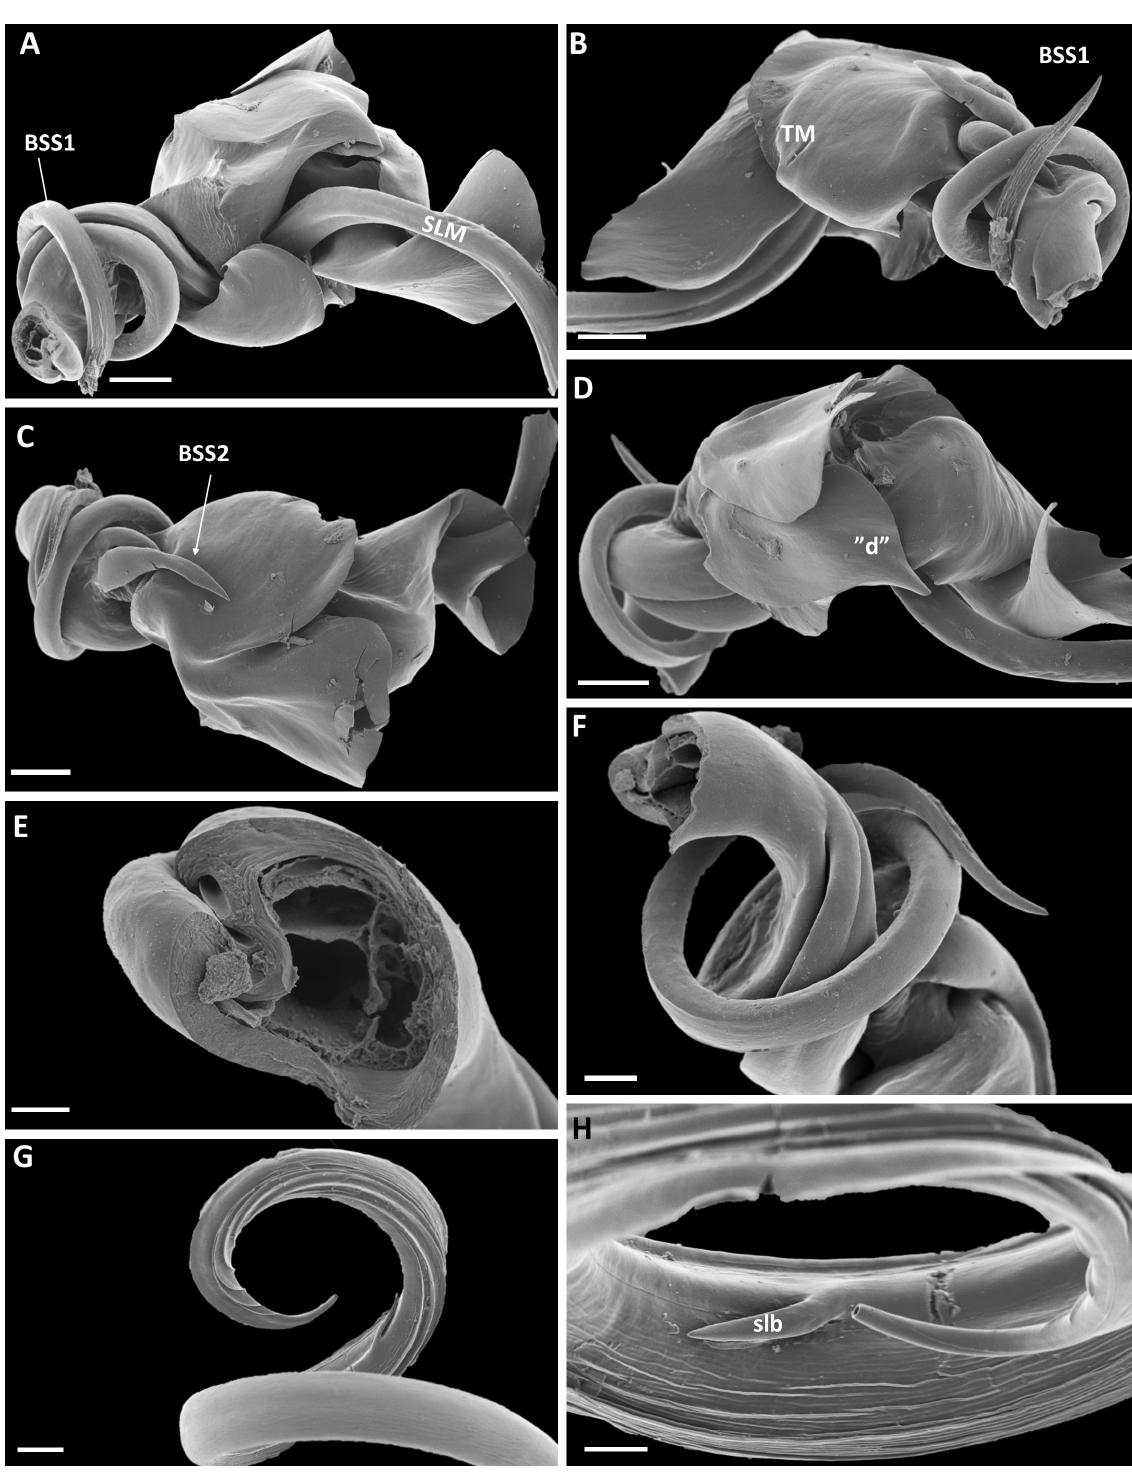
Fig. 57. Syndesmogenus estelleae sp. nov., holotype, ♂ (NHMO), right gonopod telopodite, broken through torsotope and missing basal part; distal part of solenomere also broken off. A . Anterior view. B . Posterior view. C . Ventral view. D. Dorsal view. E . Transverse ‘section’ (break) through basal part of torsotope. F . Sublateral view. G–H. Distal part of solenomere. Abbreviations: BSS1 , BSS2 = basal solenomeral spines; “ d ” = structure “d” sensu Ribaut (1907); SLM = solenomere; TM = telomere. Scale bars: A–D = 0.1 mm; E, H = 0.02 mm; F–G = 0.05